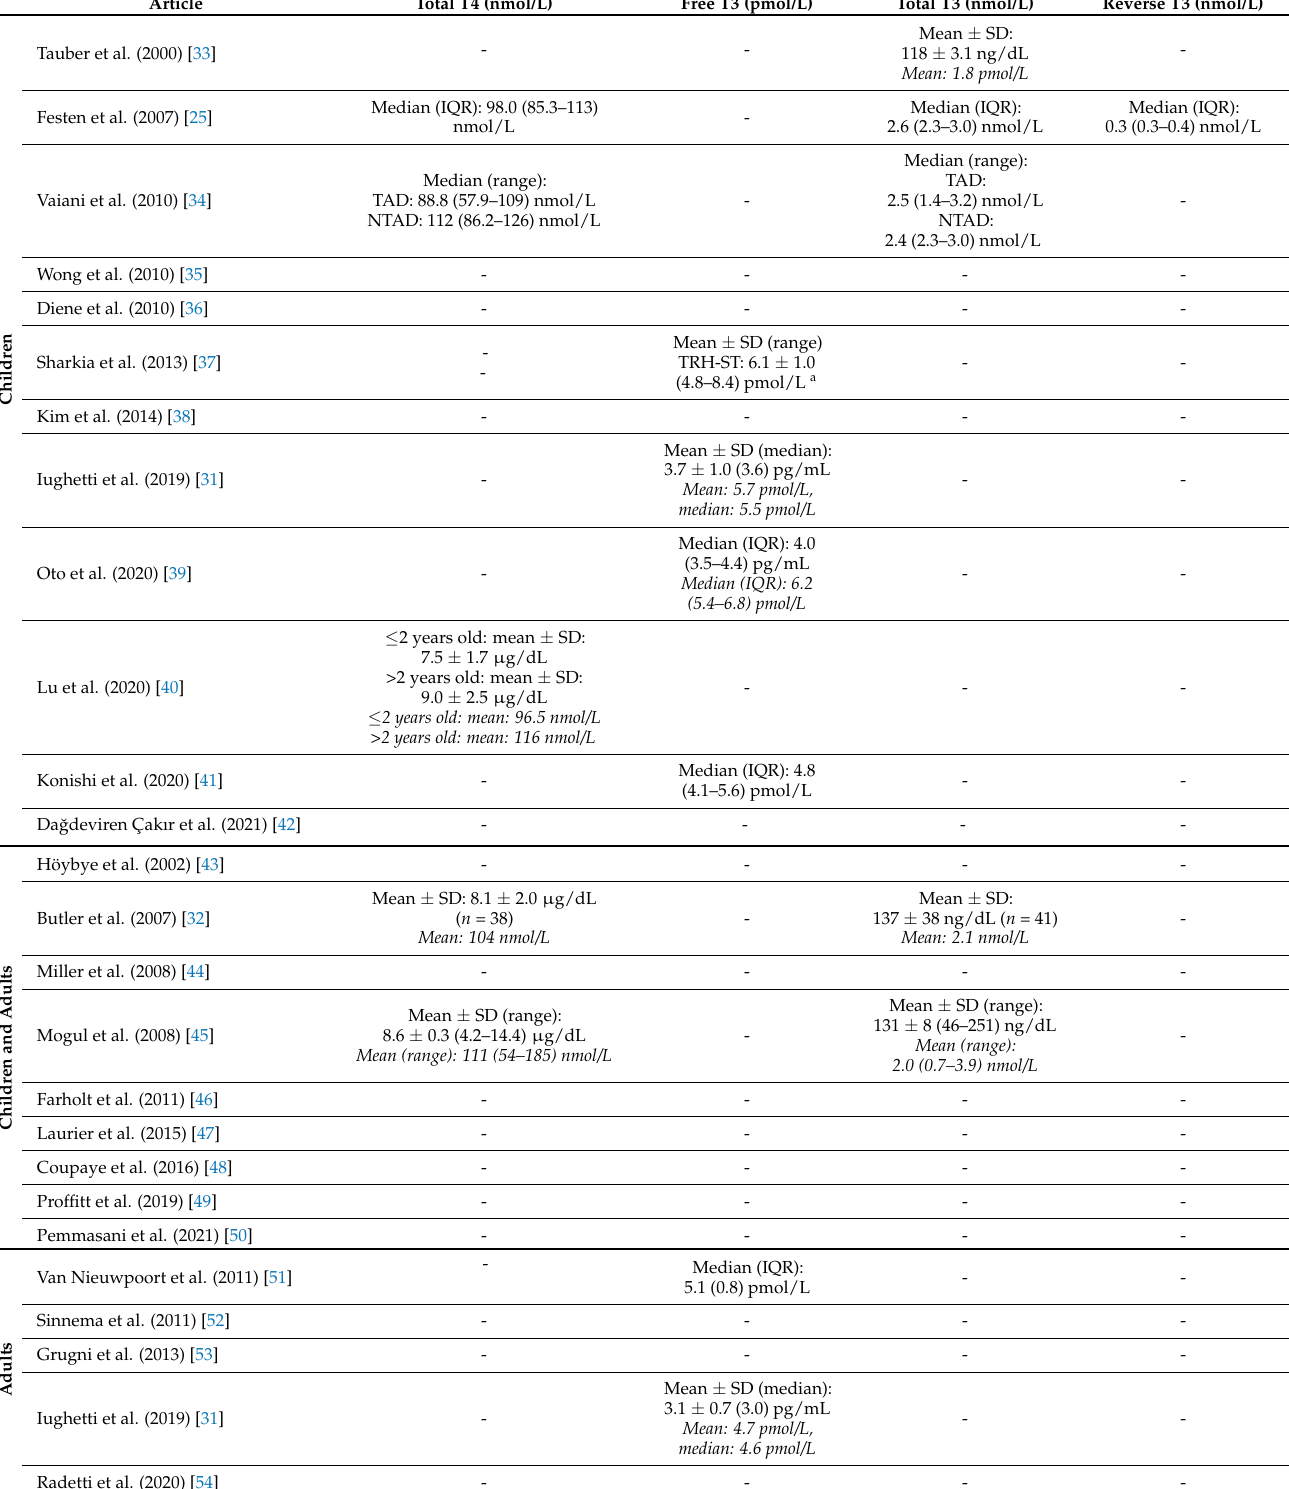
Table 7. Patient characteristics of cohorts assessed by previous studies (Part